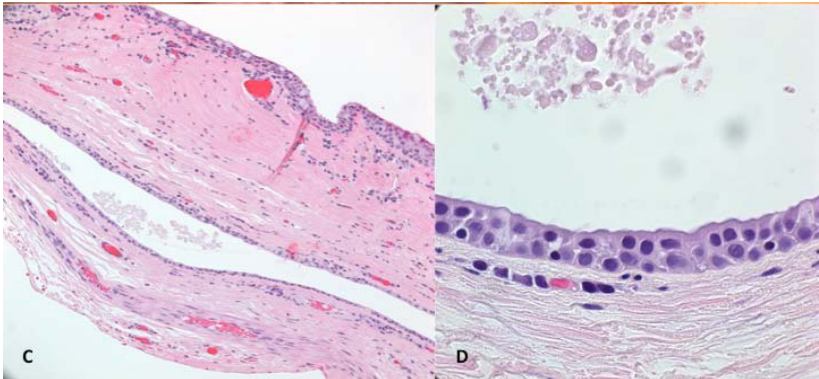
Figure 3. ( A ) Case 3—Ptosis of the left upper eyelid; ( B ) Apocrine Cystic lesion with bluish color; ( C ) Low magnification photomicrograph. Superior portion of the specimen shows conjunctival tissue with goblet cells that had been excised with cyst. The middle portion shows the cystic lining; ( D ) High magnification of the cyst lining showing multi-layered cuboidal epithelium with the luminal surface showing faint apocrine secretions most consistent with apocrine